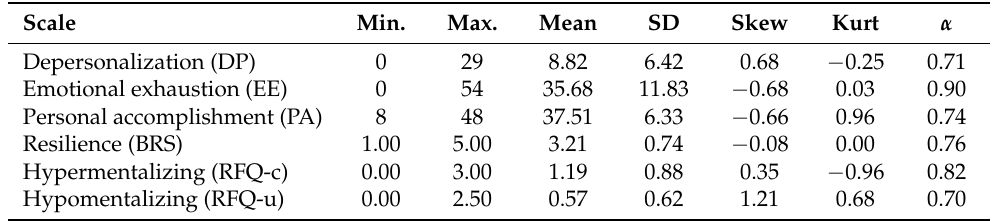
Table 1. Descriptive statistics of used measures.